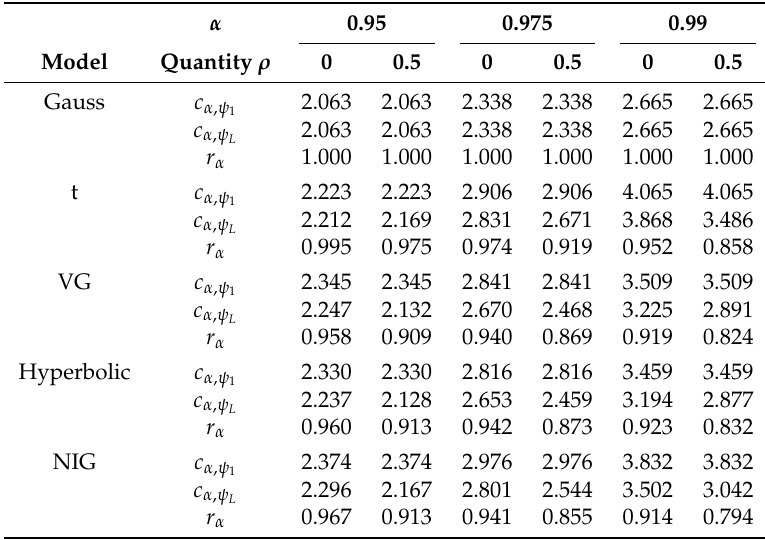
, c α , ψ and ratios r α in the experiment with two risk factors. L 1